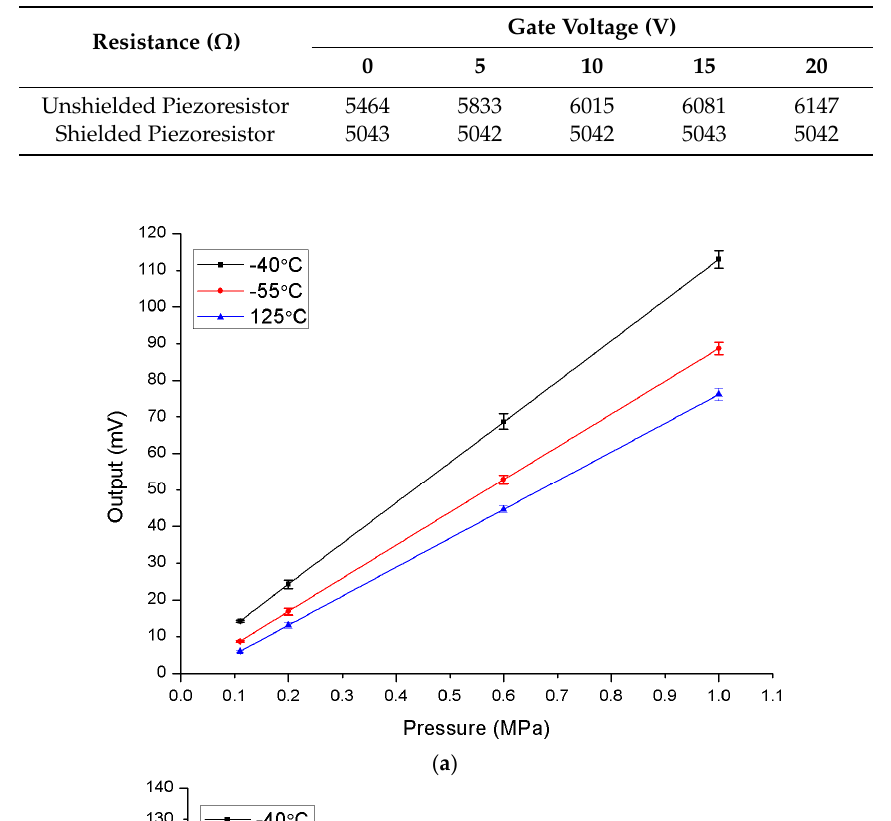
Table 2. Resistance of the piezoresistors vs. gate voltage.